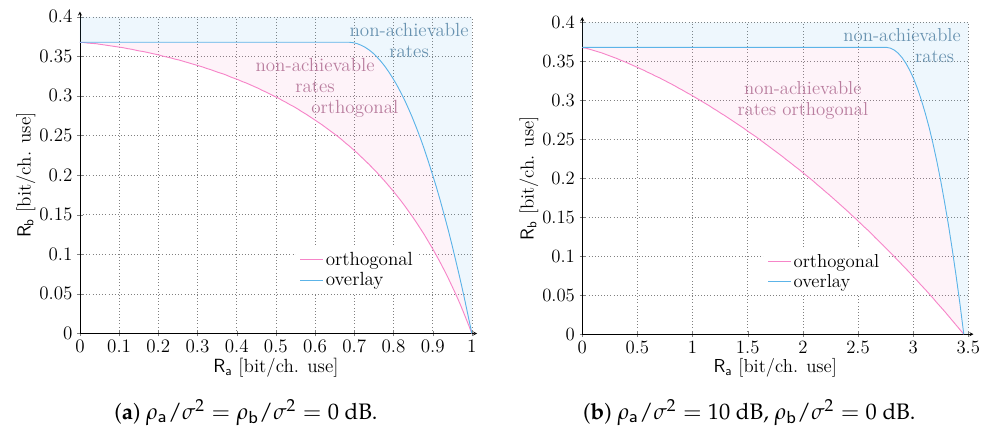
Figure 2. Asymptotic ergodic rate regions for an orthogonal and overlay allocation of resources of services S a and S b . Two scenarios are considered: ρ a / σ 2 = ρ b / σ 2 = 0 dB and ρ a / σ 2 = 10 dB, ρ b / σ 2 = 0